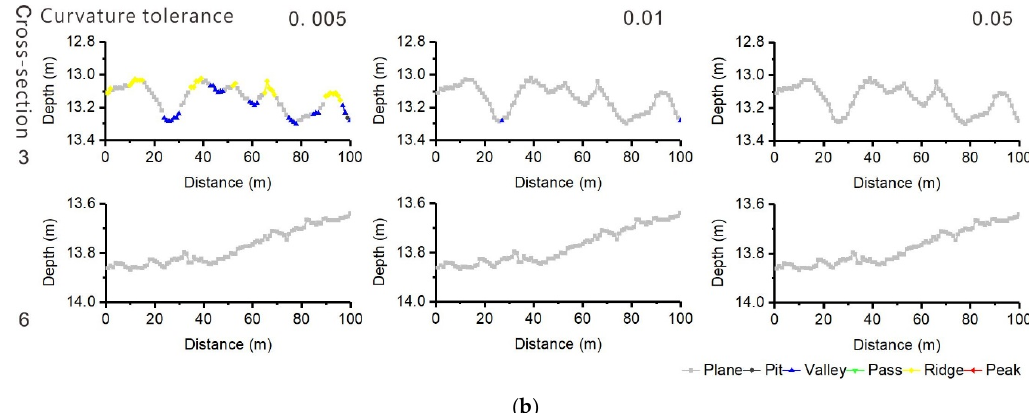
Figure 3. Water depth profiles overlaid by Wood’s criteria-based elements for ( a ) Cross-sections 1, 2, 4, and 5 under various slope tolerances, and for ( b ) Cross-sections 3 and 6 under various curvature tolerances.